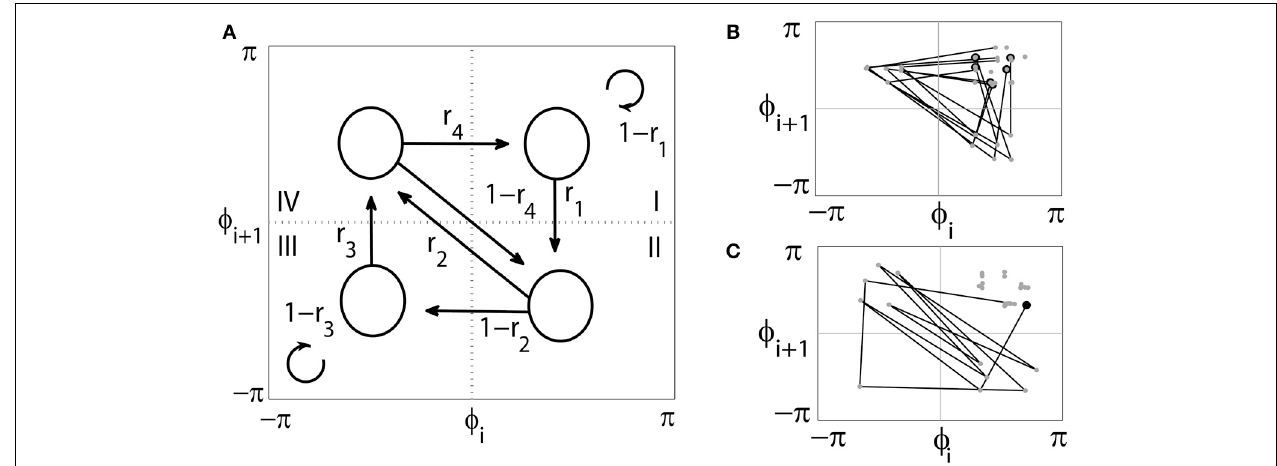
FIGURE 1 | (A) diagram of the ( φ i ,φ i + 1 ) first-return map. The arrows indicate all possible transitions from one region to another and r 1 , 2 , 3 , 4 indicate the correspondingtransitionrates.Aftertheuniformphaseshiftforallthedata,the synchronized state is in the center of the region I (which is called synchronized state too) and three other regions are desynchronized states. (B,C) present examples of two extreme cases of dynamics. (B) numerous short